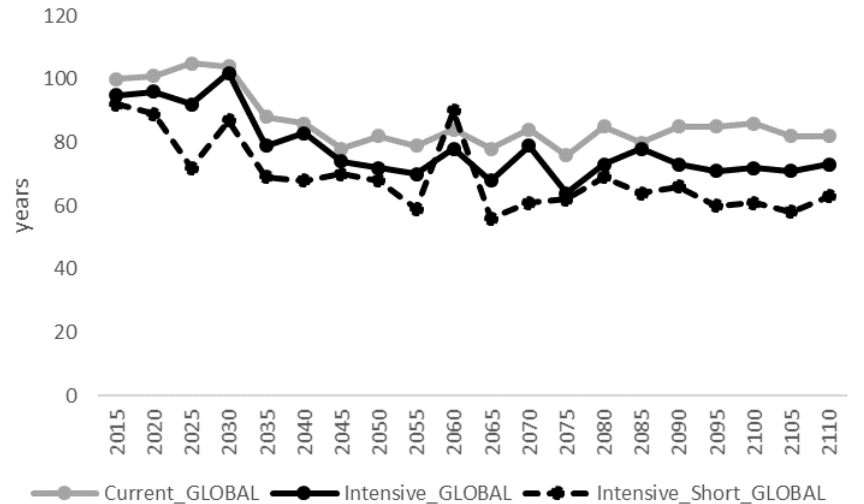
Figure 10. Projected average rotations (i.e., age at final felling) with current forest management approaches of different intensities in the GLOBAL BIOENERGY scenario.